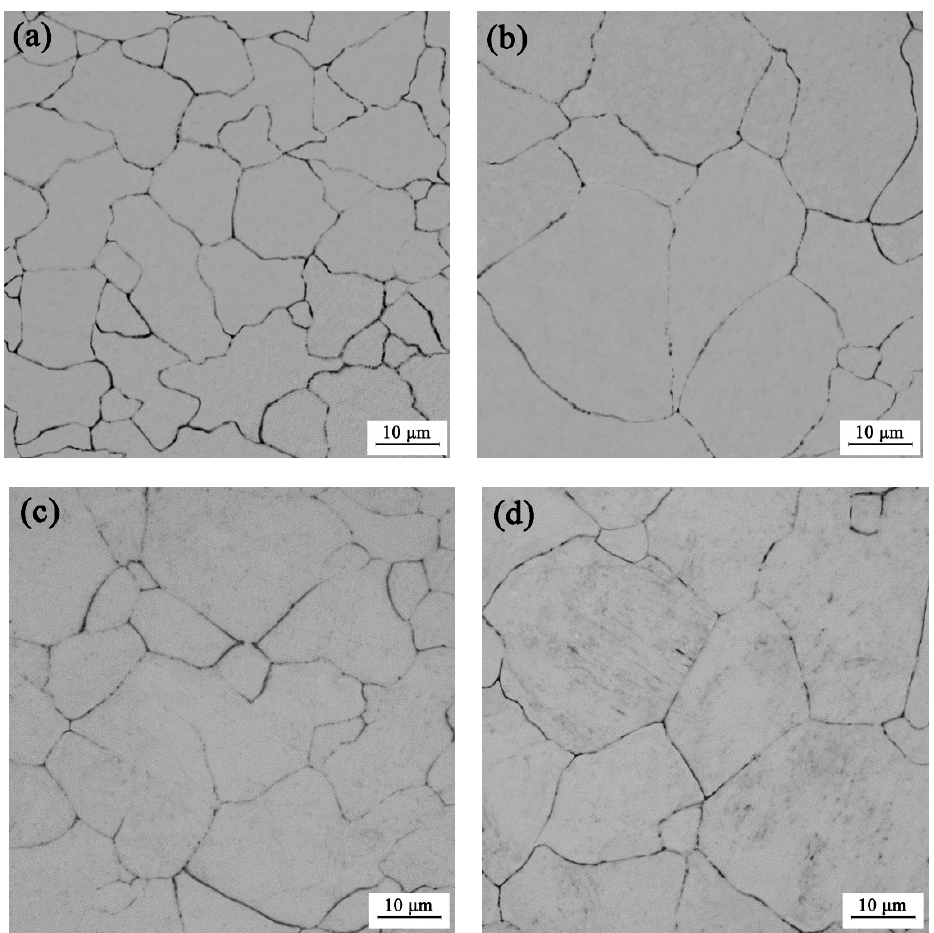
Figure 13. Microstructures of the hot deformed material under the deformation conditions of: ( a ) 1000 °C/0.1 s − 1 , ( b ) 1100 °C/0.1 s − 1 , ( c ) 1100 °C/1 s − 1 and ( d ) 1150 °C/1 s − 1 . ( a ) 1000 ◦ C / 0.1 s − 1 , ( b ) 1100 ◦ C / 0.1 s − 1 , ( c ) 1100 ◦ C / 1 s − 1 and ( d ) 1150 ◦ C / 1 s − 1